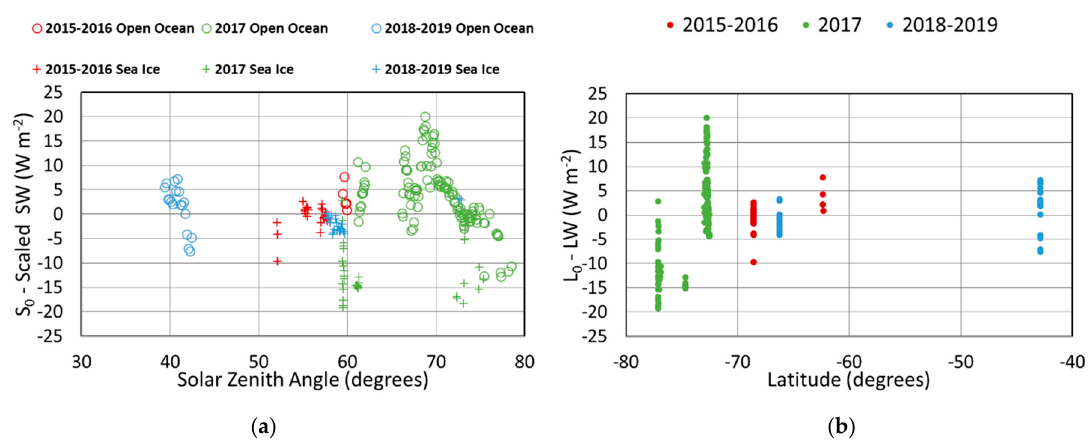
Figure 4. Residuals for clear-sky radiation models for each season. ( a ) S 0 —scaled observed SW irradiance (the observed SW irradiance divided by the regression coefficient m in Table 1) as a function of solar zenith angle. Distinction is made between conditions of open ocean (open circles) and sea ice (crosses). ( b ) L 0 —observed LW irradiance as a function of latitude.